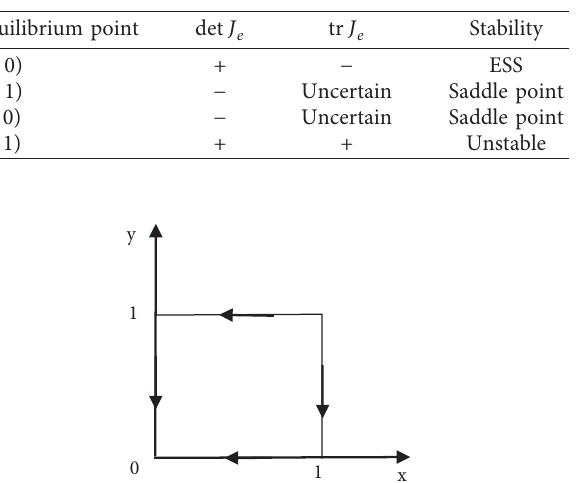
Table 5: Analysis of partial equilibrium table.